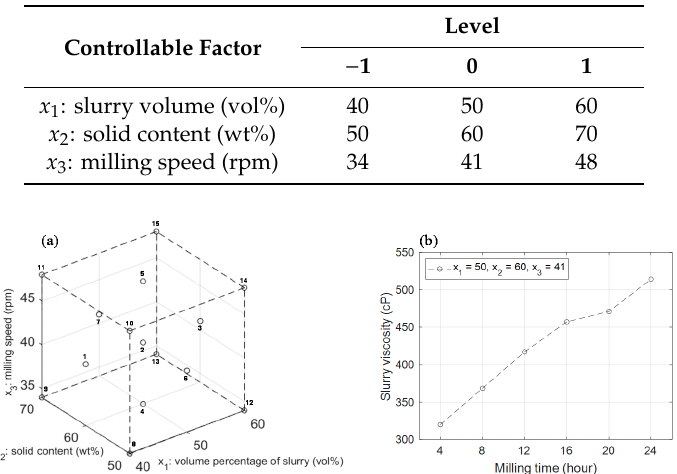
Figure 3. ( a ) Arrangement of 15 tests designed by CCD; ( b ) measured values of slurry viscosity at the center point. Table 2. Experiment dataset collected from the target ball mill by conducting 15 tests designed by CCD.